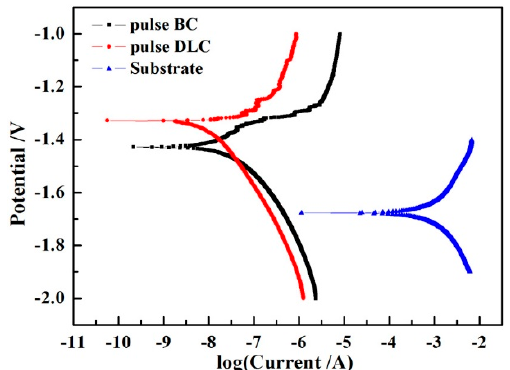
Figure 8. Polarization curves of AZ91D Mg-alloy substrate, MAO coatings by pulse bipolar current and pulse with a discharge loop current power supply mode.